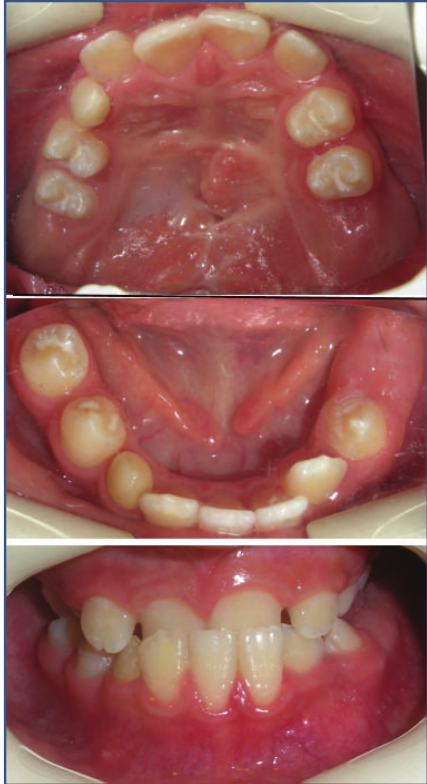
Figure 6: Intraoral appearance of the patient after